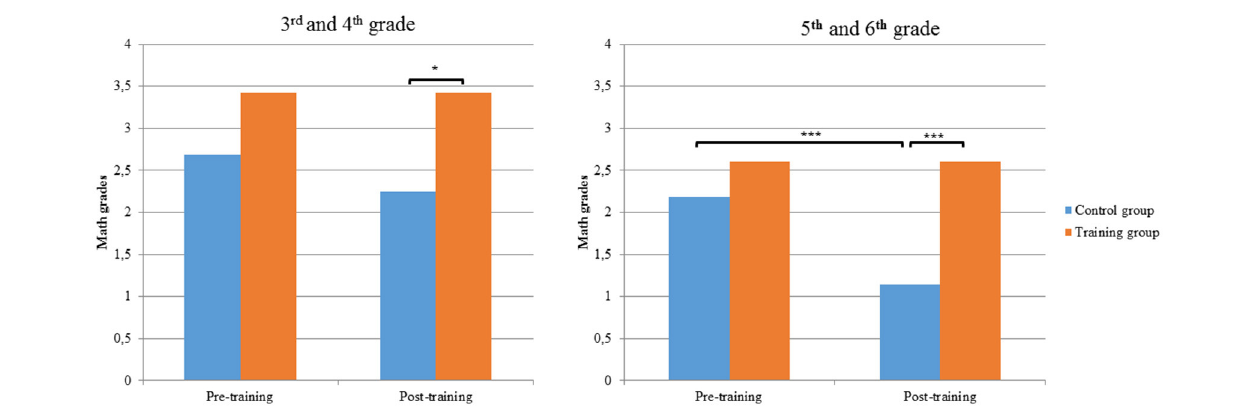
FIGURE 1 | Training vs. control groups in math grades separated by stage: 2nd stage (3rd and 4th grade) and 3rd stage (5th and 6th grade); (* p < 0.05; *** p < 0.001).